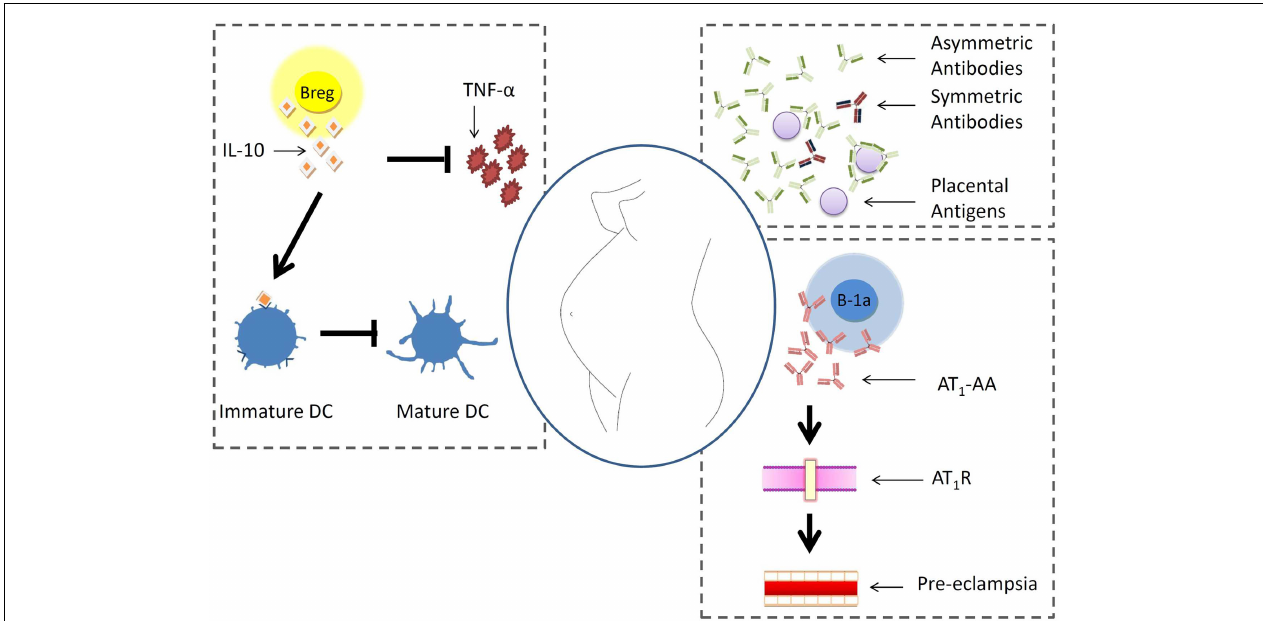
autoimmune disorders, it is possible that B cells secrete more autoantibodies and endanger the gestation. A newly described B cell type, the so-called regulatory B cells, produces IL-10 and is proposed to positively influence pregnancy by hinderingTh1 immune